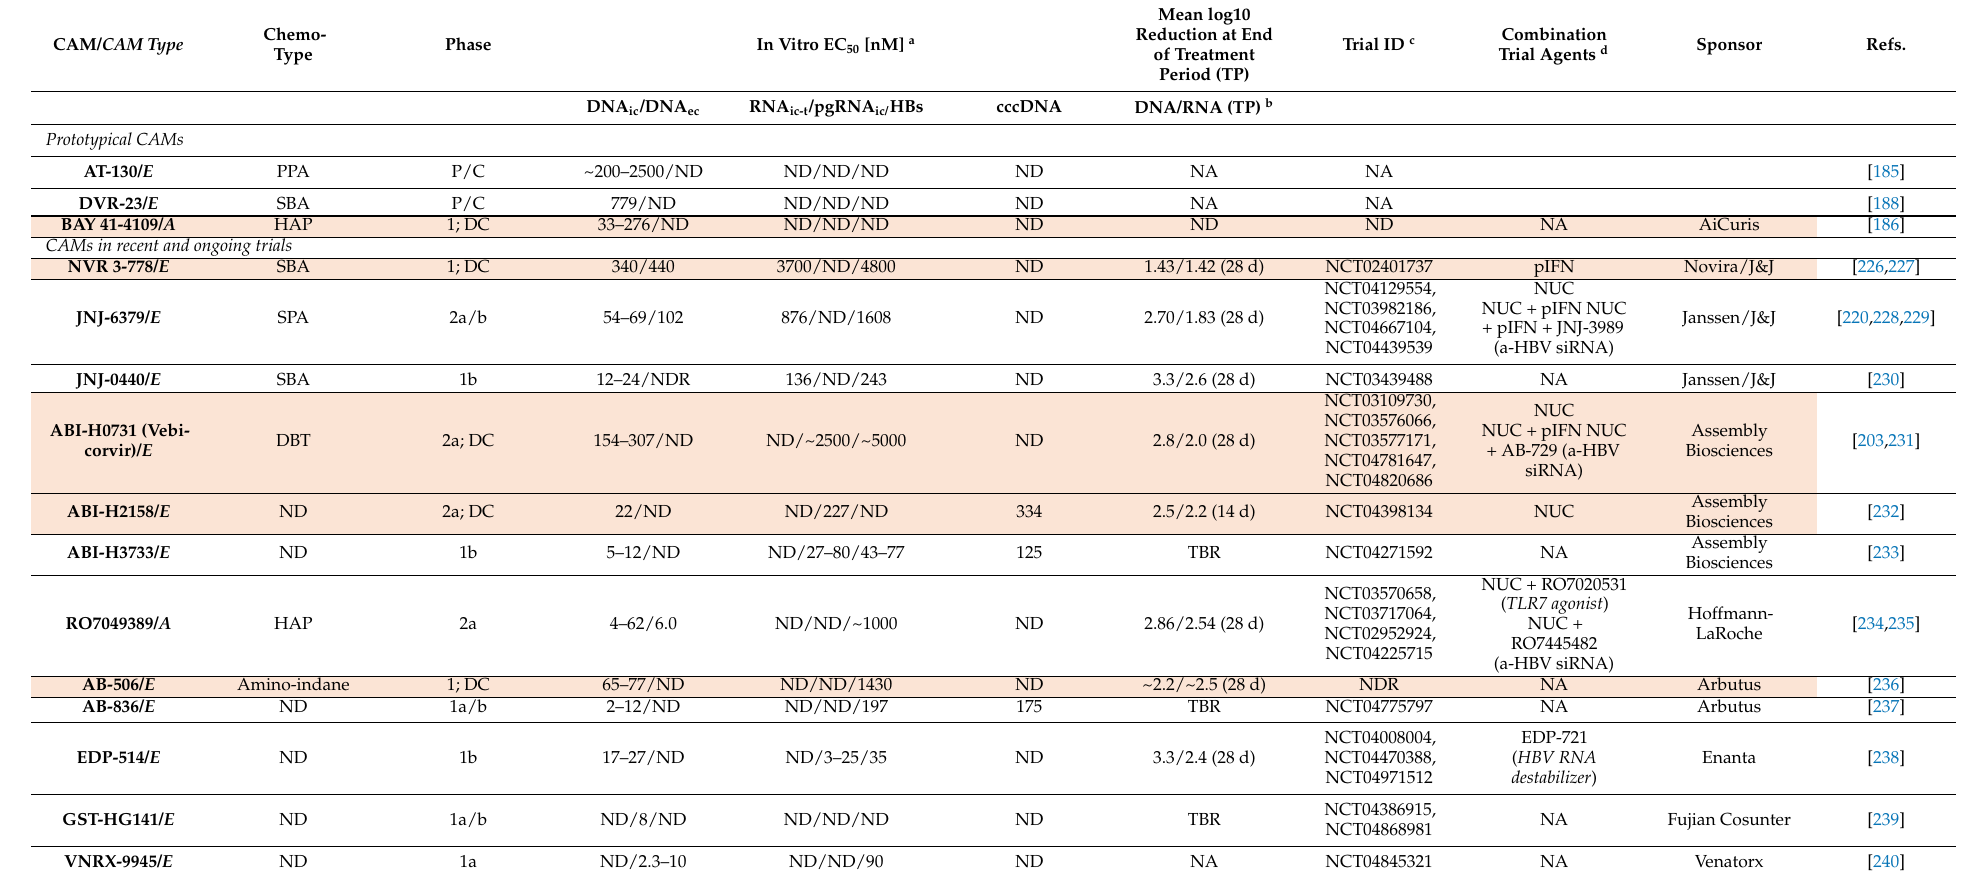
Table 1. Anti-Hbv activities of CAMs in preclinical and clinical